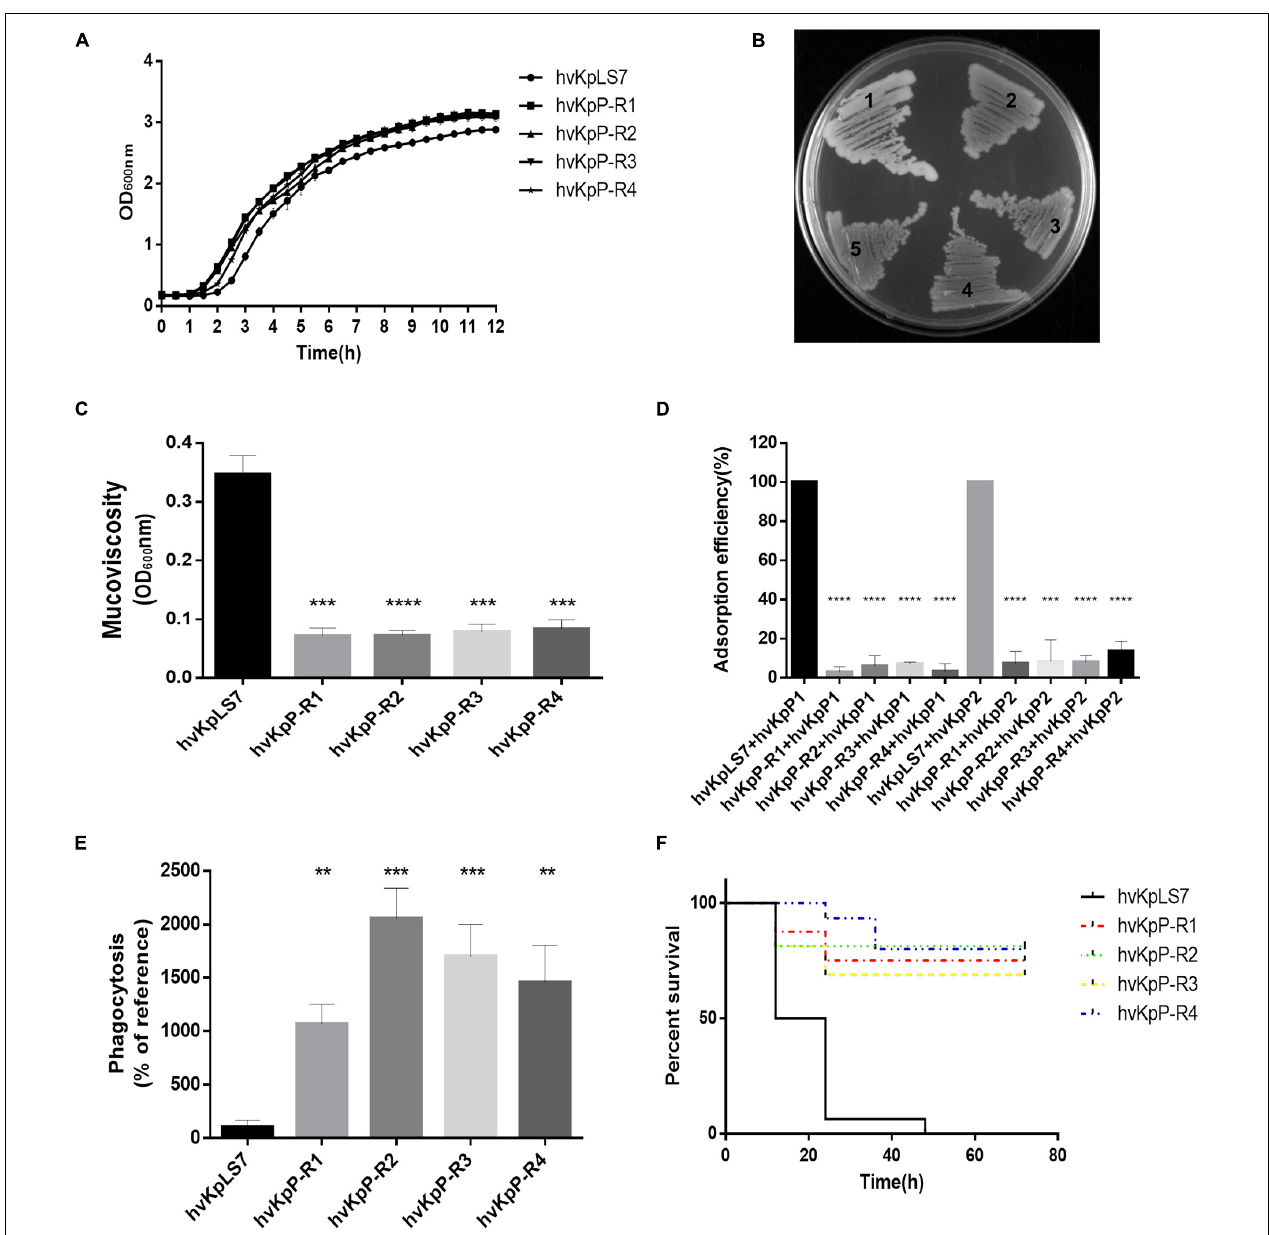
FIGURE 4 | Characterization of phage-resistant K. pneumoniae . (A) Growth curves of the WT and mutant of K. pneumoniae strains. (B) Morphology comparison between colonies of K. pneumoniae on an LB agar plate. hvKpLS7 (mucoid, moist, and sticky) and phage-resistant mutant (dry, rough, and transparent). (C) Centrifugation analysis of hvKpLS7, hvKpP-R1, hvKpP-R2, hvKpP-R3, and hvKpP-R4. (D) Adsorption efficiencies of hvKpP1 and hvKpP2 binding to K. pneumoniae hvKpLS7, hvKpP-R1, hvKpP-R2, hvKpP-R3, and hvKpP-R4. (E) Phagocytosis by RAW264.7 macrophages. (F) Survival of G. mellonella larvae. The one-way ANOVA test was performed to determine statistically significant differences between each mutant and hvKpLS7. ** p < 0.01, *** p < 0.001, **** p <